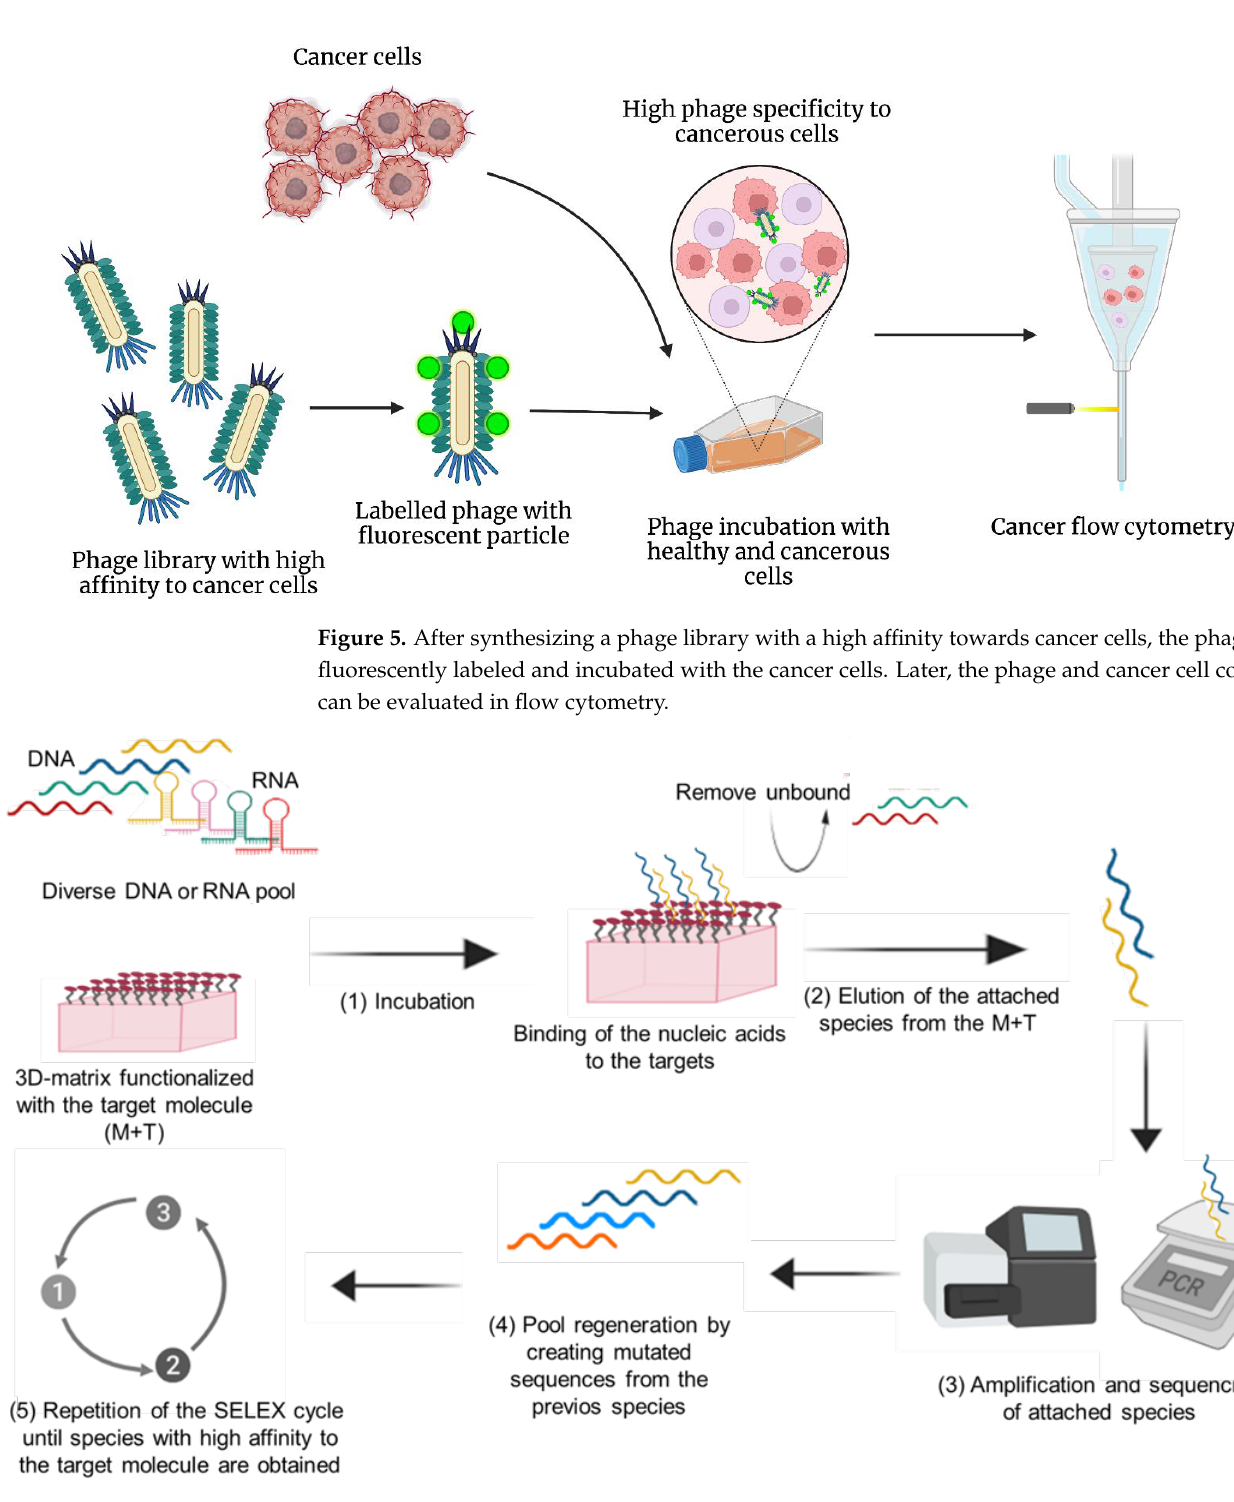
Figure 6. Aptamer development using systematic evolution of ligands by exponential enrichment (SELEX): ( 1 ) A pool of diverse nucleic acids is incubated with a matrix functionalized with the target molecule; ( 2 ) unbound nucleic acids are removed while bound nucleic acids (attached species) are eluted; ( 3 ) the eluted nucleic acids (attached species) are amplified and sequenced; ( 4 ) the pool is regenerated by creating mutated sequences of the species from the previous step; ( 5 ) repetition of the SELEX cycle until species with high affinity to the target molecule are obtained.